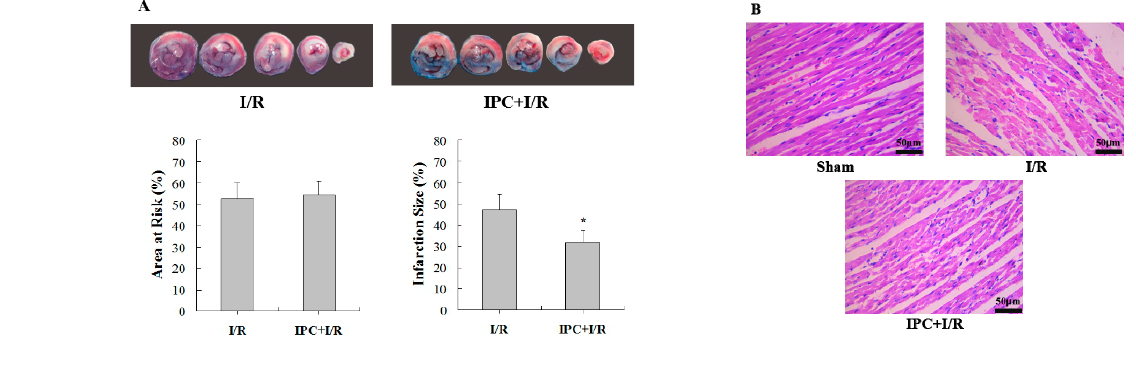
Figure 1. Cont. Figure 1.